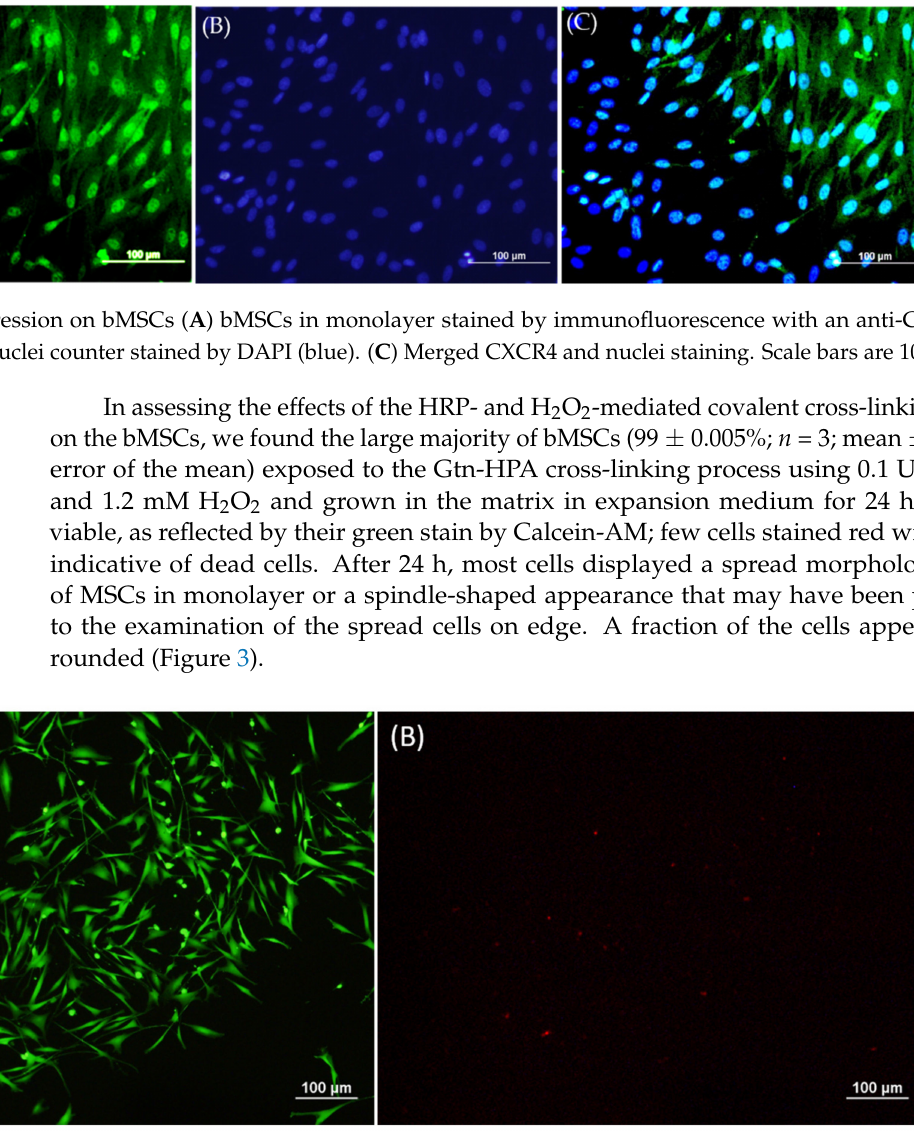
Figure 3. Cell viability after 24 h culture in Gtn-HPA matrix. ( A ) Live cells stained by Calcium AM. ( B ) Dead cells stained by EthD-1. Scale bars are 100 µ